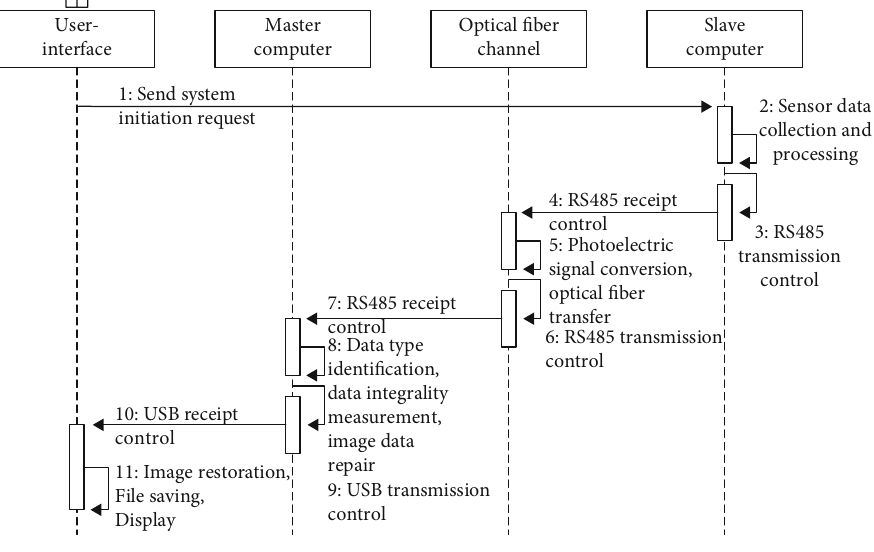
Figure 3: System work fl ow.